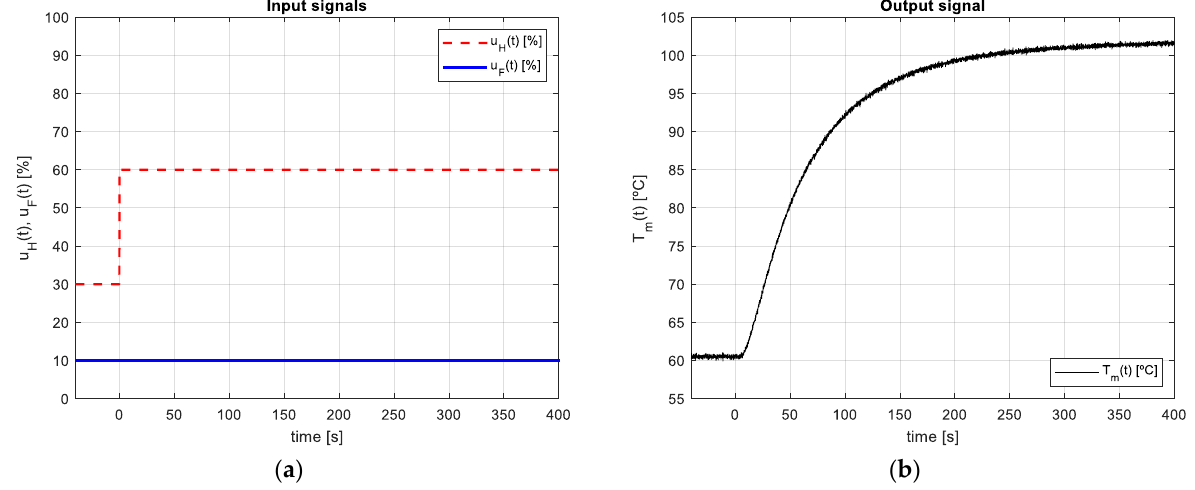
Figure 9. Experimental data obtained from a step test for identification of the process model in the controlled process configuration #1: ( a ) Control signal u H (t) [%] and command signal to air fan u F (t) [%]; ( b ) Process reaction curve T m (t) [°C] at a certain operating point.